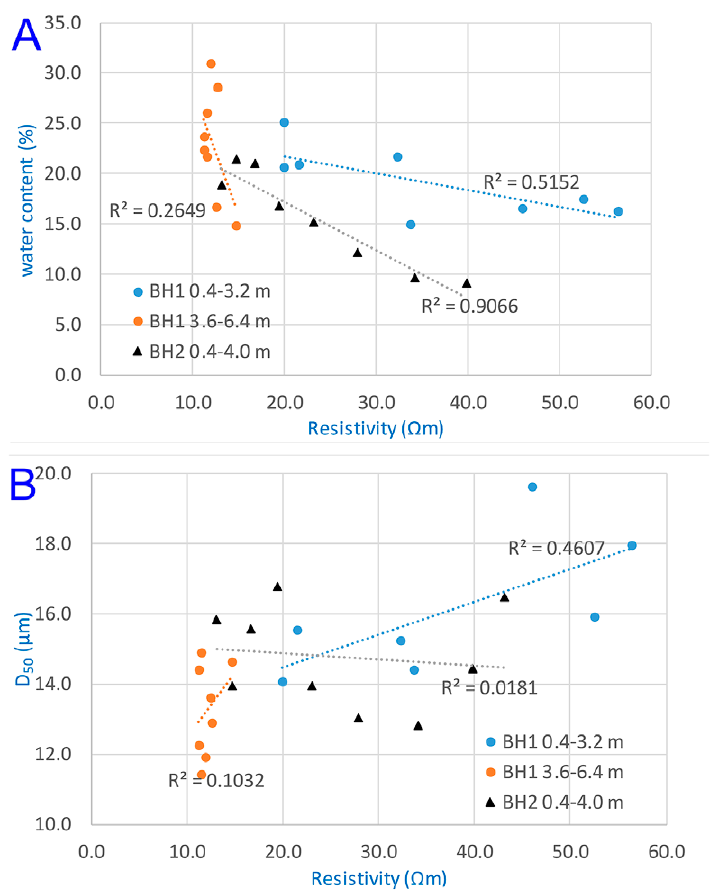
Figure 6. Relationship between A) specific resistivity and water content and B) specific resistivity and grain size in different structural units of the levee